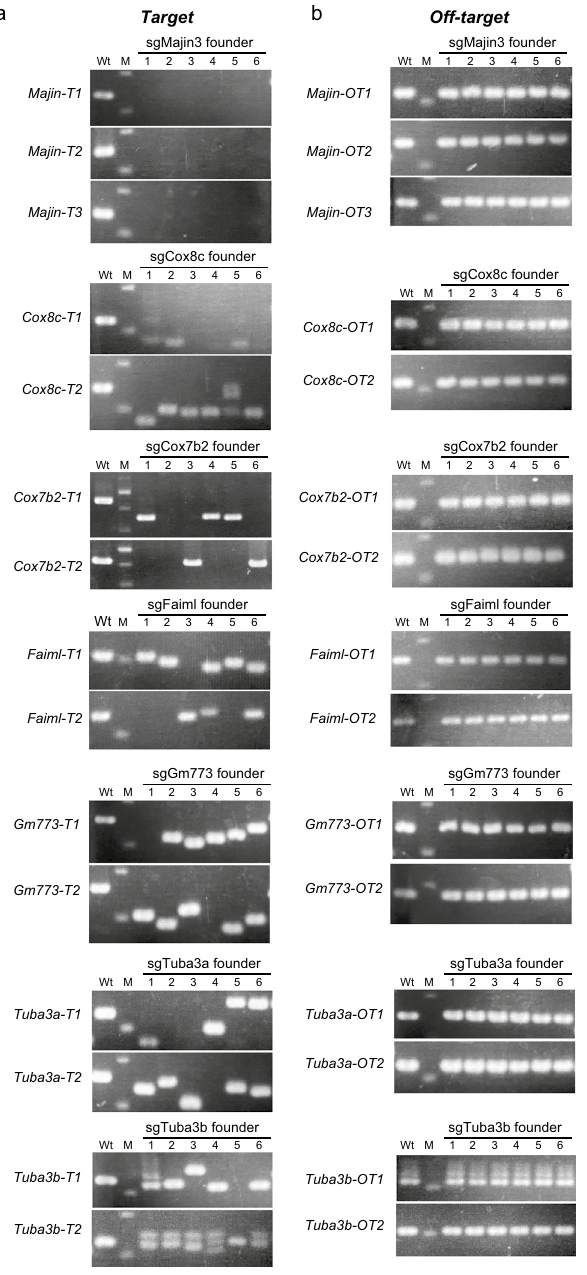
Figure 3. Highly efficient induction of indels at the target sites of the founder mice. ( a ) Electrophoresis images of genotyping PCR using pairs of primers that surround target sites of each sgRNA. Note that essentially all founders analyzed appeared to have biallelic indels at the target SRRGs. ( b ) Electrophoresis images of genotyping PCR using pairs of primers that surround the top ranked putative off-target site of each sgRNA. No apparent mutation was found at these off-target sites. M, marker (100 bp ladder); Wt, wild type. Full-length gels are presented in Supplementary Figure